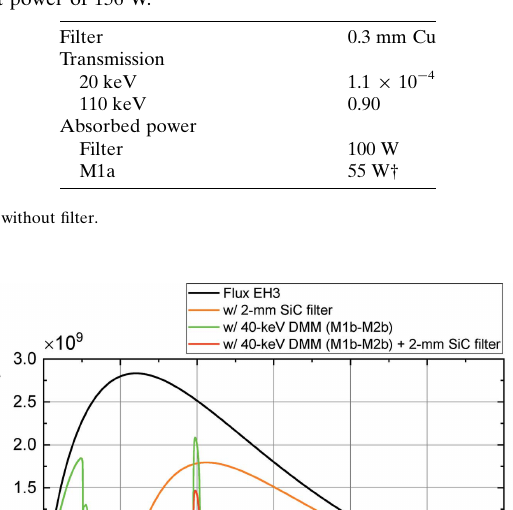
Table 3 Filter transmissions and absorbed powers for the 40 keV DMM with an incident power of 195 W.